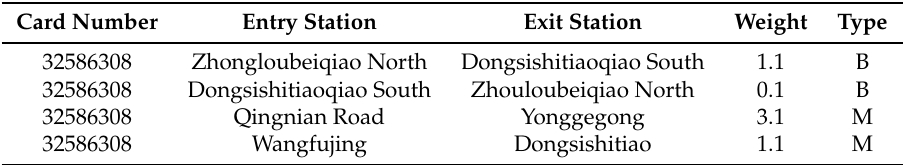
Table 1. Pre-processed